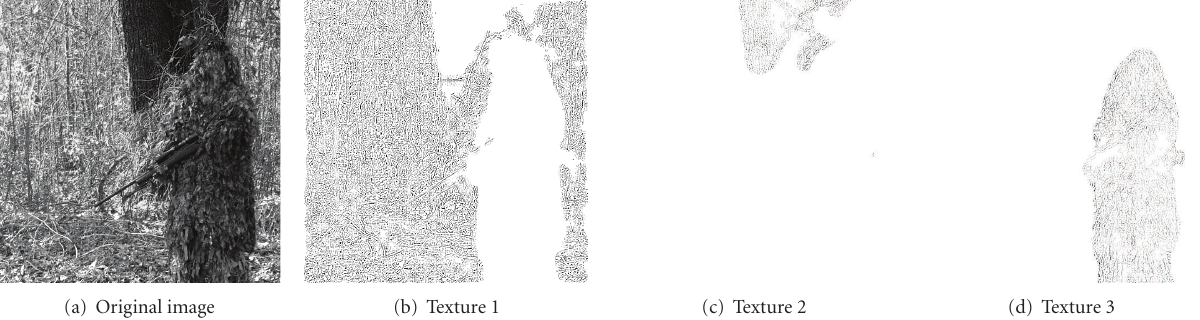
Figure 6: Sniper detection by using adaptive PDE transform method. Textures 1, 2, and 3 are, respectively, from the forest, the tree trunk, and the sniper.